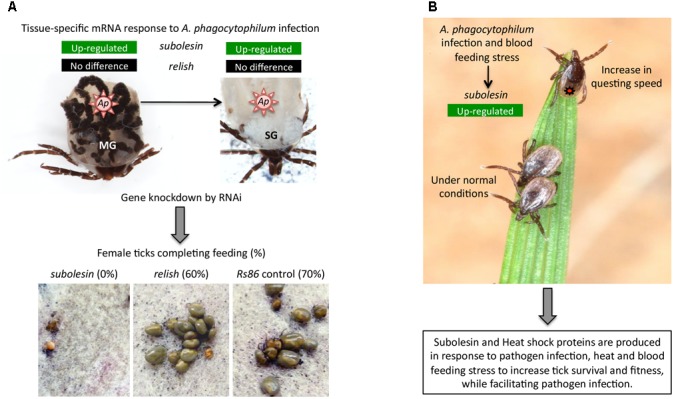
Examples of the role of tick Subolesin in different biological processes | (A) Role of tick Subolesin in A. phagocytophilum infection and blood feeding. The transcriptomics analysis in different I. scapularis tick tissues showed that subolesin (ISCW023283) but not relish (ISCW018935) mRNA levels significantly increased in response to A. phagocytophilum (Ap) infection in both midgut (MG) and salivary glands (SG). In addition, the subolesin gene knockdown phenotype in ticks injected with dsRNA resulted in a significant reduction in the number of female ticks completing feeding, oviposition and fertility. Results were reported by Ayllón et al. (2015). Photo of dissected I. scapularis partially fed adult female ticks courtesy of K. M. Kocan (Oklahoma State University, United States). (B) Role of tick Subolesin in A. phagocytophilum infection, blood feeding and questing speed. The response to A. phagocytophilum and stress increases subolesin levels, which together with heat shock proteins improve tick questing speed and survival. Results were reported by Busby et al. (2012). Photo of questing Ixodes ricinus courtesy of L. Grubhoffer & J. Erhard (Biology Center of the AS CR, Institute of Parasitology, Czechia).